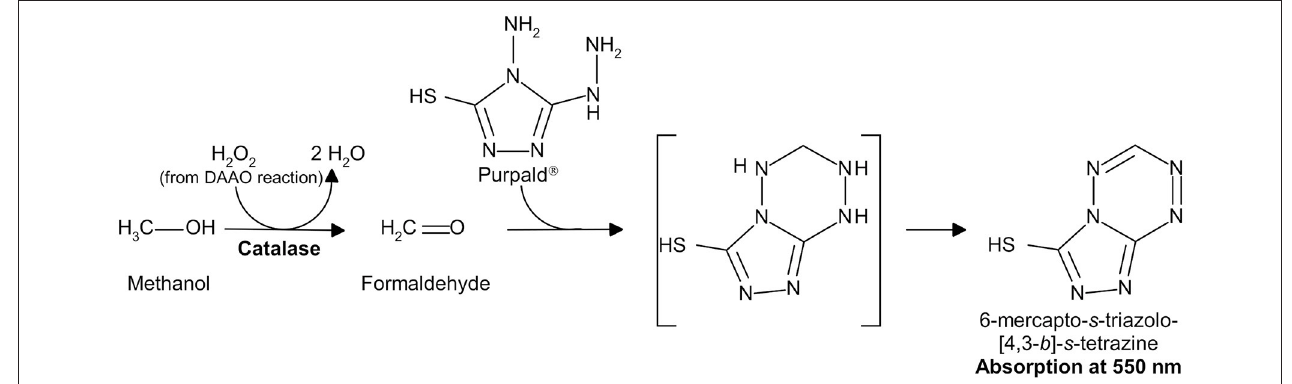
FIGURE 3 | Detection of hydrogen peroxide produced by DAAO in a catalase-coupled reaction using Purpald ®